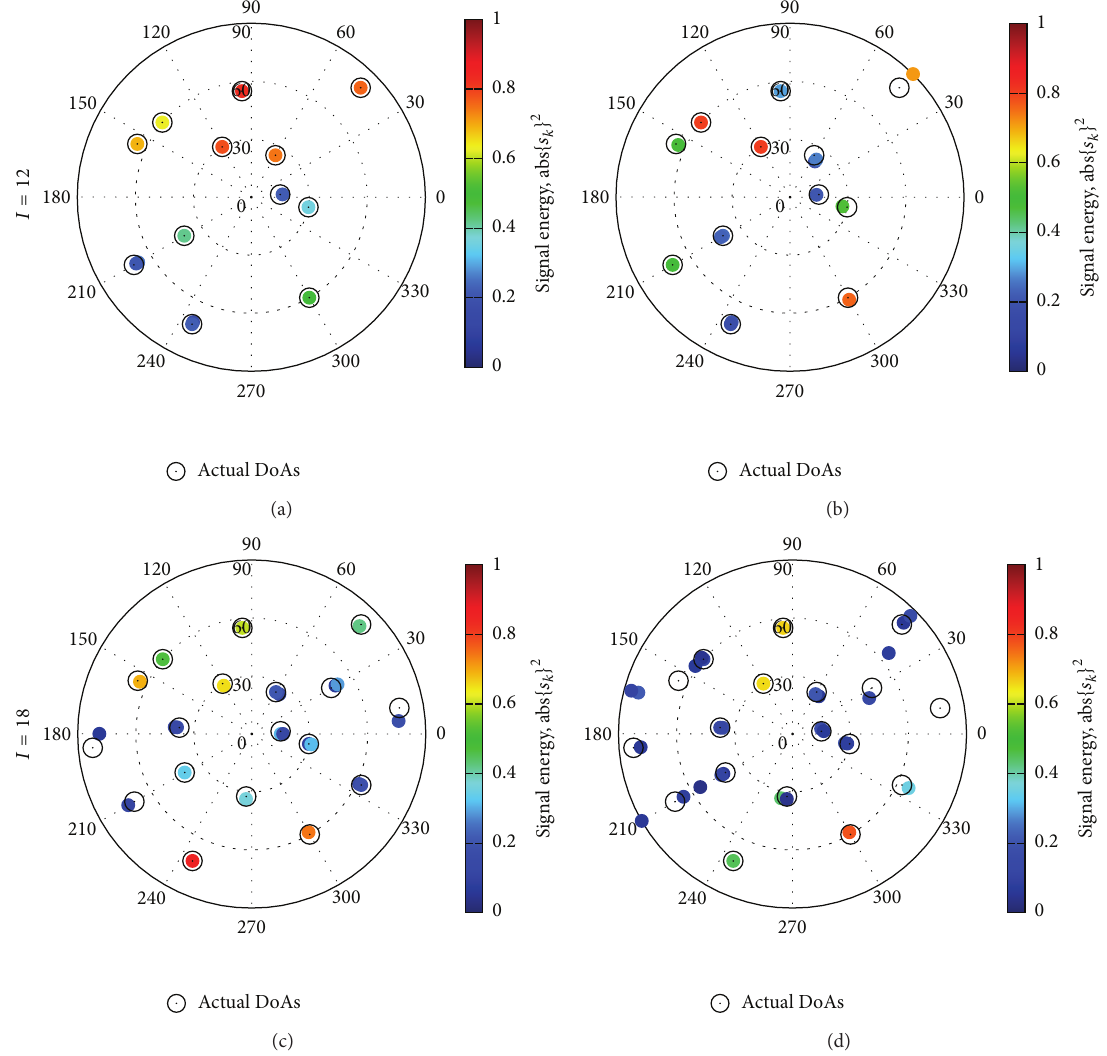
Figure 7: Fully populated array—( 𝑁 = 25 ; 𝑑 𝑥 = 𝑑 𝑦 = 0.5𝜆 ; 𝐼 = {12, 18} ; SNR = 10dB; 𝑇 = 25 ; 𝐶 = 50 )—plot of the best (left column) and worst (right column) estimations obtained by means of the MT-BCS among the 𝐶 different noisy scenarios when (a) (b) 𝐼 = 12 and (c) (d) 𝐼 = 18